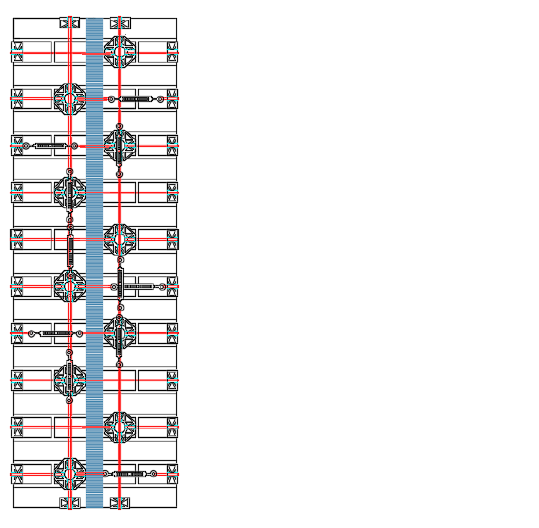
Figure 57. Scheme of the arrangement of the steel wire ropes in the second combined technique.